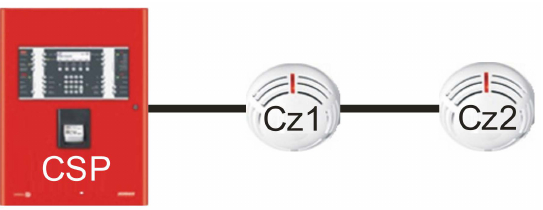
Figure 7. Simplified FAS diagram. CSP (FACU)—fire alarm control unit, Cz1, Cz2—detectors within the system detection